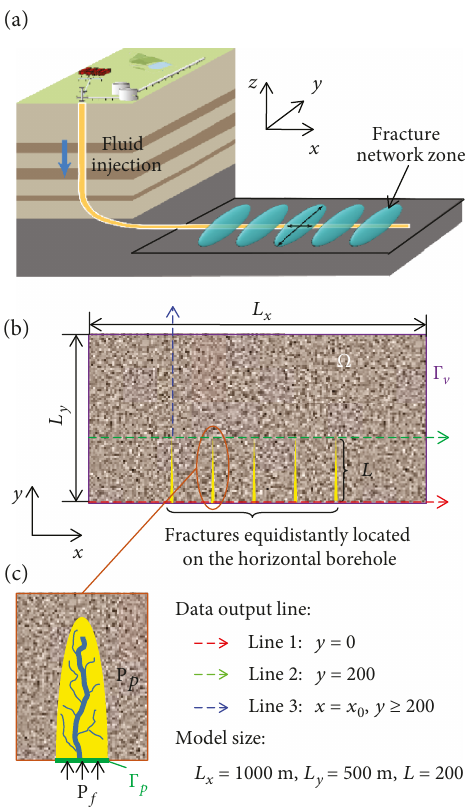
Figure 1: Numerical model of the pore pressure disturbance by hydraulic fracturing. Modelled domain size = 1000 × 500 m. The fracture network of each stage is represented by an elliptical zone (semimajor axis = 200 m, short axis = 2 m) with high